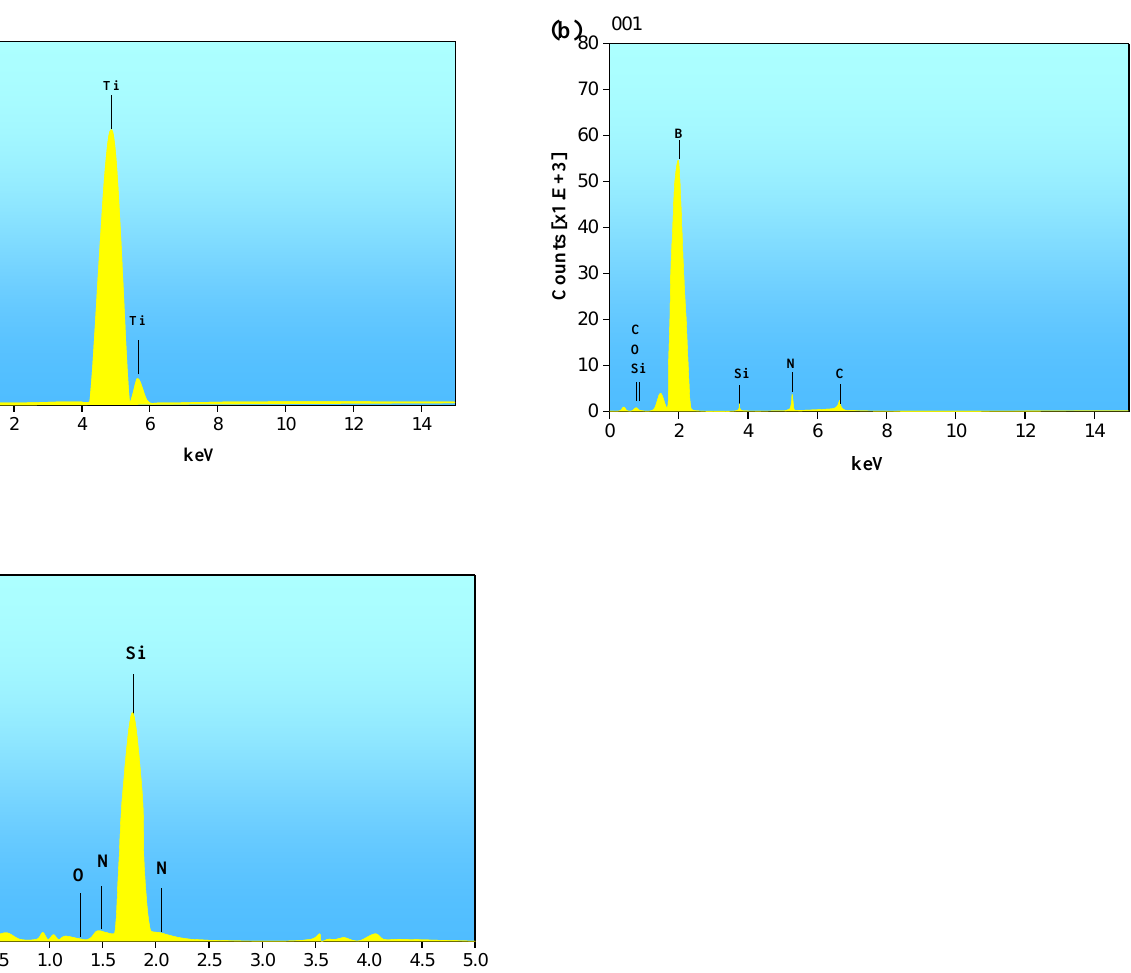
Figure 4. EDX analysis of ( a ) TiB 2, ( b ) B 4 N, and ( c ) Si 3 N 4 .